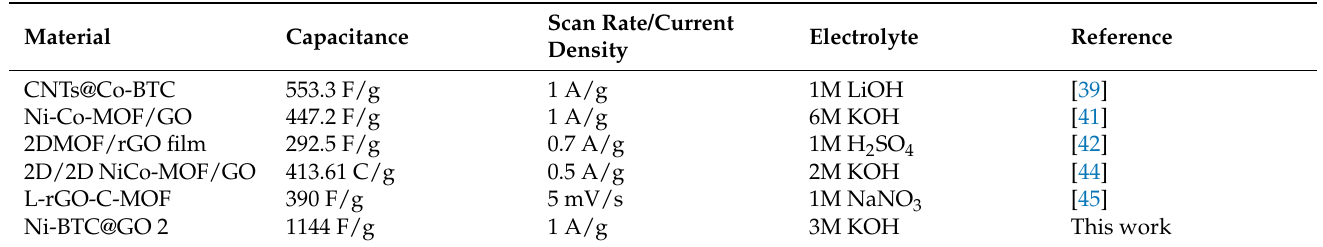
Table 1. Comparison of the electrochemical performance of similar MOF@GO composites reported in the literature.